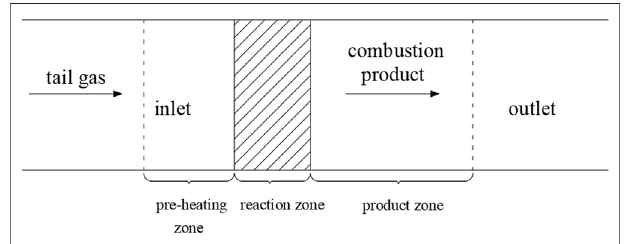
FIGURE2| One-dimensional laminar fl amecombustion physical model.